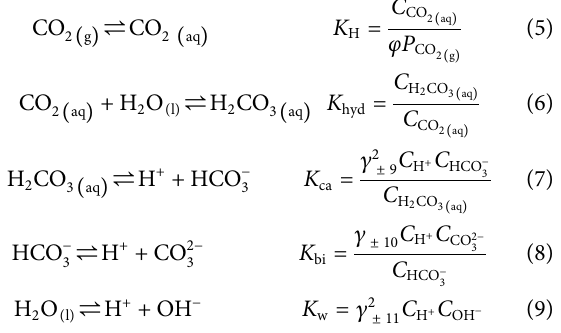
Frontiers in Materials |